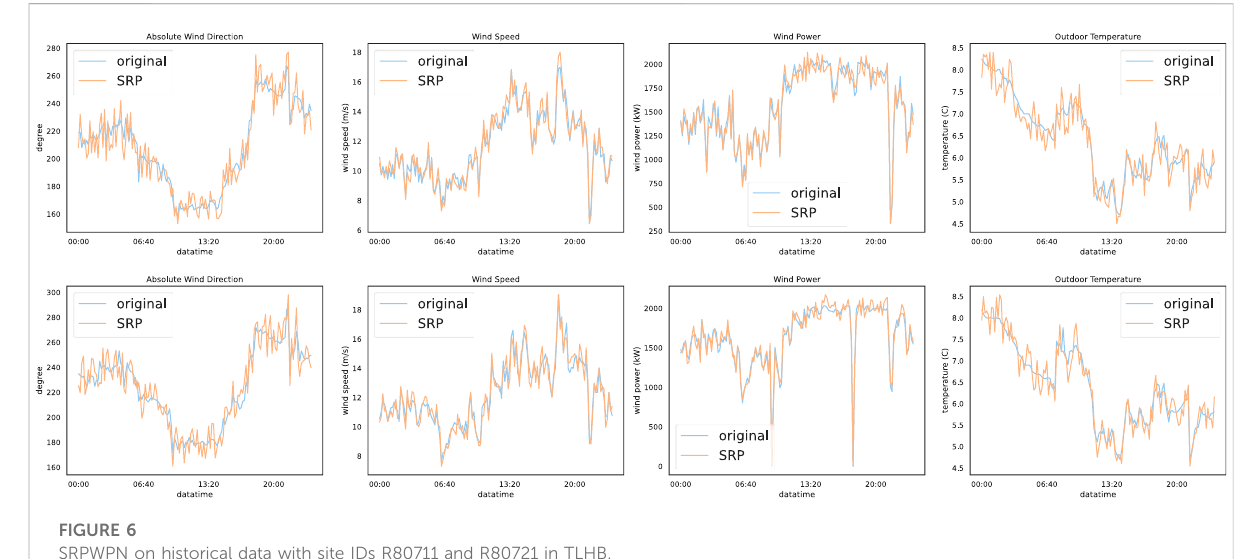
FIGURE 6 SRPWPN on historical data with site IDs R80711 and R80721 in